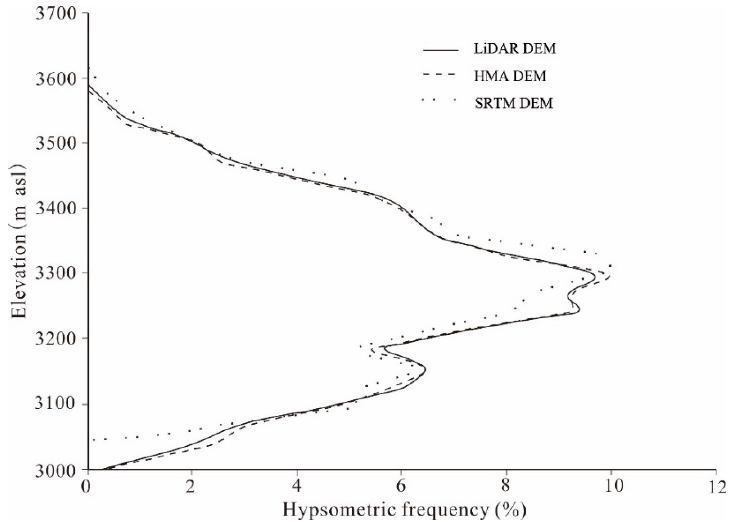
Figure 5. Watershed hypsometry for the DEM extracted from the LiDAR DEM, high–resolution stereo pairs and the SRTM DEM.